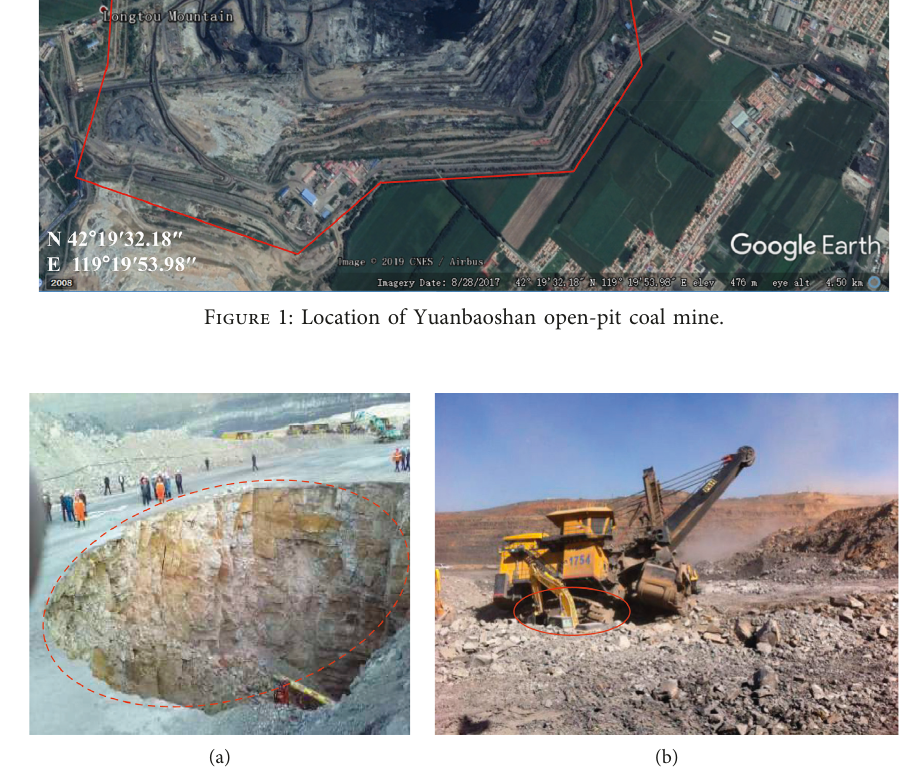
Figure 2: Safety accident scene in the open-pit mine due to underground goaf. (a) Due to the insufficient safety thickness of the roof of unknown goaf, heavy truck fell into the underground goaf 30m deep. (b) During the mining process of the open-pit coal mine, the track on the right side of shovel fell into the collapsed underground